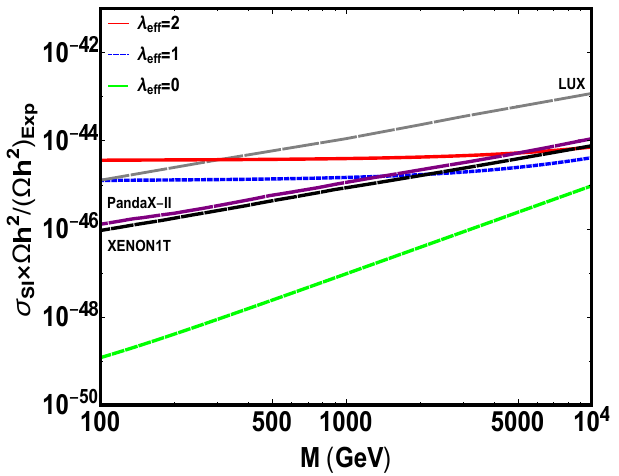
Figure 4 . DM-nucleus scattering cross section as a function of the dark matter mass for n = 7. The solid (red), dotted (blue), and dashed (green) lines correspond to (cid:21) e(cid:11) = 2, 1, 0 respectively. The gray, purple and black long dashed lines give the exclusion limits of LUX, PandaX-II and XENON1T